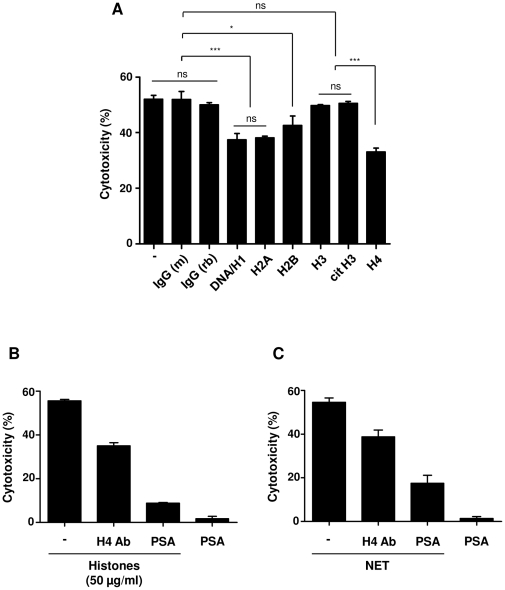
Histone antibodies and polysialic acid decrease NET-mediated cytotoxicity.(A) NET were pre-incubated with different antibodies against histones (DNA/H1, H2A, H2B, H3, citrullinated H3 [cit H3], H4) or with isotype-matched control antibodies. Antibody-treated NET or NET alone (−) were incubated with A549 cells for 16 h to analyze the cytotoxicity. Shown are representative data of three independent experiments (mean  SD), ***p<0.001 and ns = non-significant. (B) Histones or (C) NET were pre-incubated with antibody against histone H4 or polysialic acid (PSA), followed by incubation with A459 cells for 16 h to analyze the cytotoxicity. Note that polysialic acid considerably decreased both histone- and NET-mediated cytotoxicity.